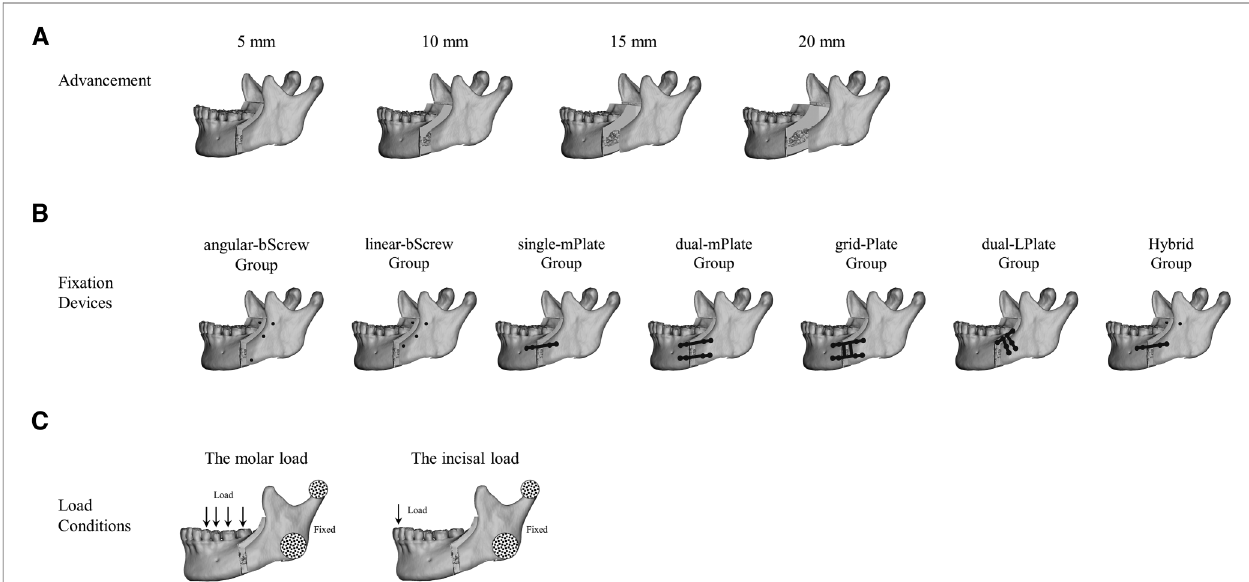
FIGURE 1 | Mandibular sagittal split ramus osteotomy was performed on the intact mandible models. The forward advancement of the distal segment was set up to 5, 10, 15, and 20 mm ( A ). Seven types of fi xation methods were positioned in the osteotomy models ( B ). Molar and incisal loads were applied to all models to simulate bite forces ( C